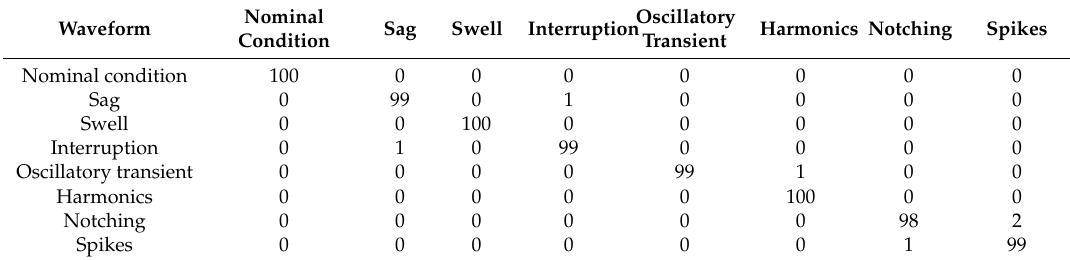
Figure 5. ( a ) Synthetic signal, ( b ) magnitude tracking, ( c ) constructed signal for the fundamental component, and ( d ) H tracking. Table 2. Confusion matrix for synthetic signals.